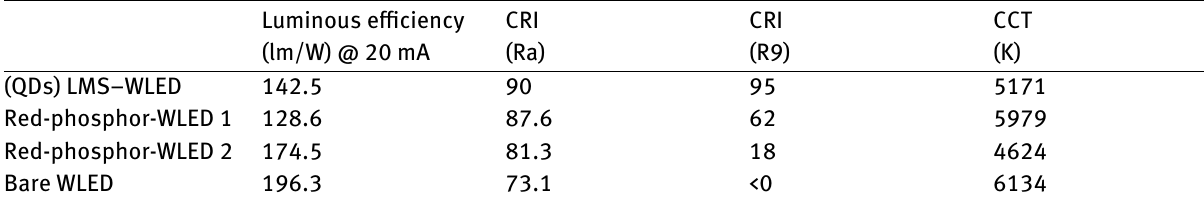
Table 1: Light performance of as assembled WLEDs.